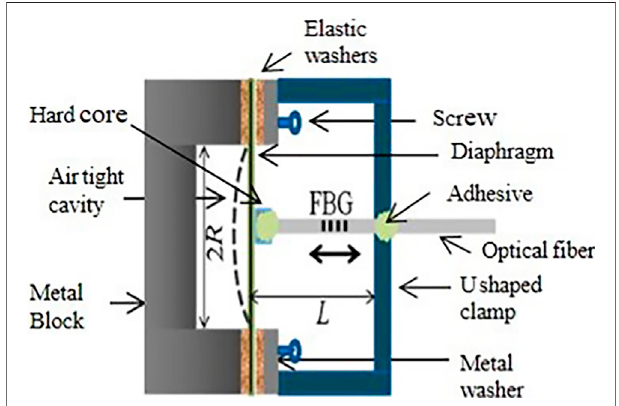
FIGURE 1 | The schematic structure [25].